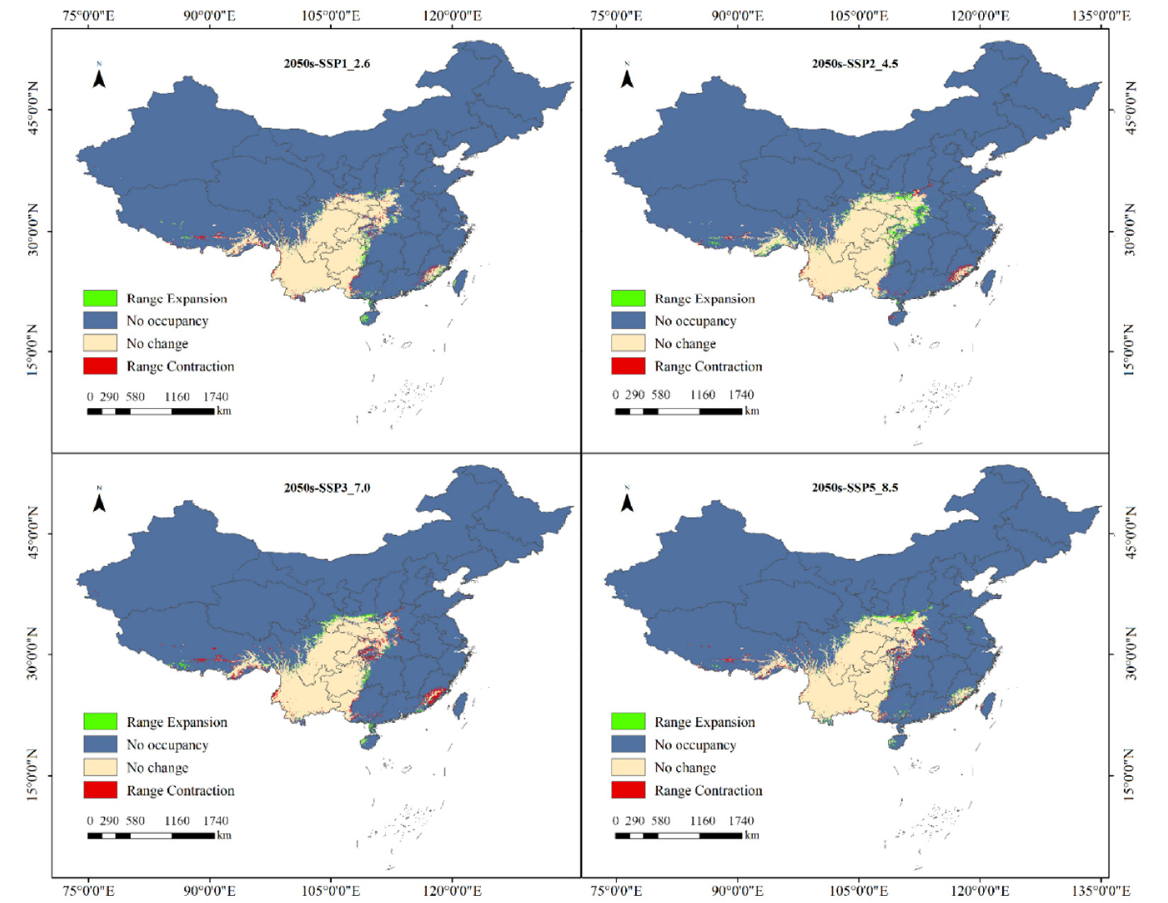
Figure 5. Changes in the suitable habitats of S. delavayi under four climate scenarios in the 2050s. Under the four climate scenarios from the present to the 2090s, all suitable habitats only increased in the SSP3 scenario (2.57%), and the other three scenarios showed decreasing trends, among which the smallest reduction occurred in the SSP1 scenario ( − 0.11%), and the most evident reduction occurred in the SSP5 scenario ( − 1.87%). The area of highly suitable habitats also showed a decreasing trend, with the most considerable decrease in the SSP5 scenario ( − 18.78%). The areas of moderately suitable habitats all showed increasing trends, among which the largest increase was under the SSP3 scenario (10.54%). The area of poorly suitable habitats showed a decreasing trend (Table